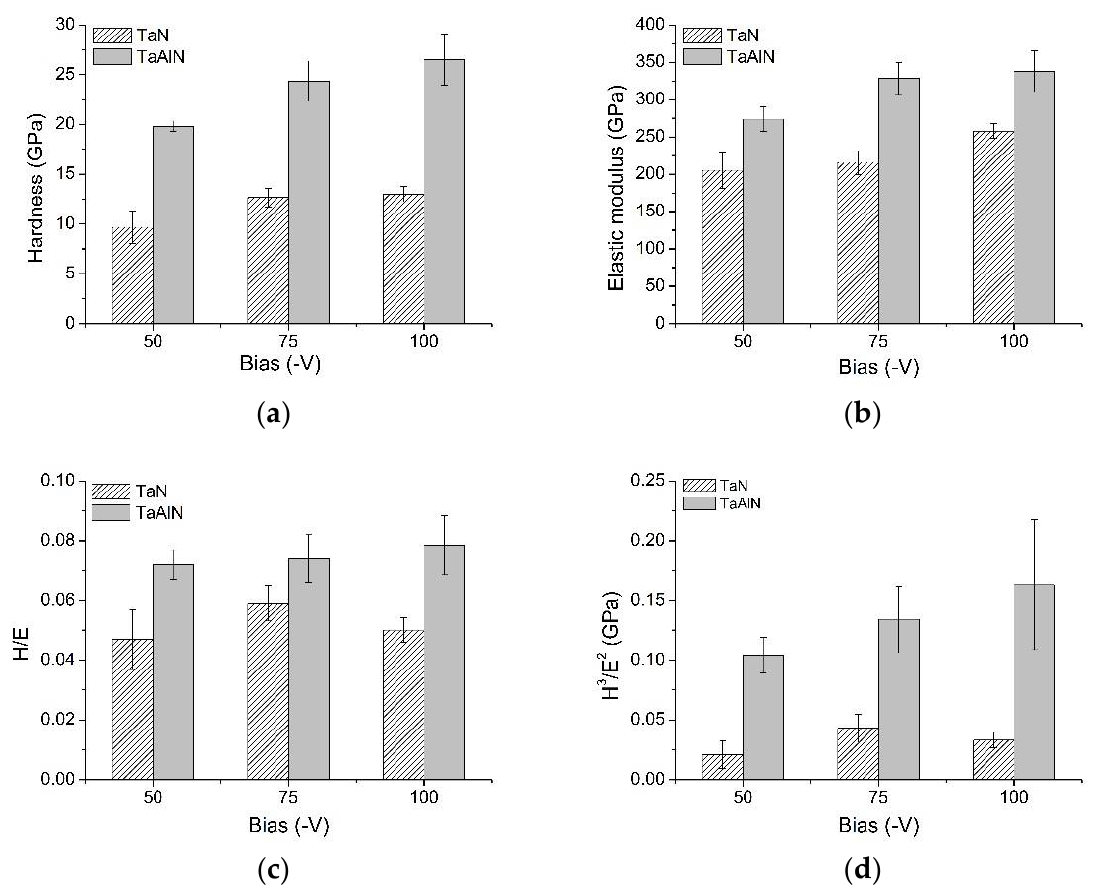
Figure 7. Mechanical properties, as estimated from nanoindentation measurements: ( a ) hardness, ( b ) elastic modulus, ( c ) elastic strain to failure H/E, and ( d ) resistance to plastic deformation H 3 /E 2 .